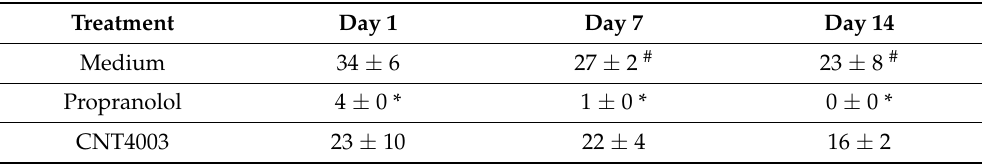
Table 3. Ciliary beating frequency (Hz) in EpiAirway™ tissues after exposure to negative control, positive control (propranolol) or CNT4003. Significant differences ( p < 0.05) between treated and untreated samples are indicated by an asterisk. Significant changes over time of the untreated tissues are marked by a